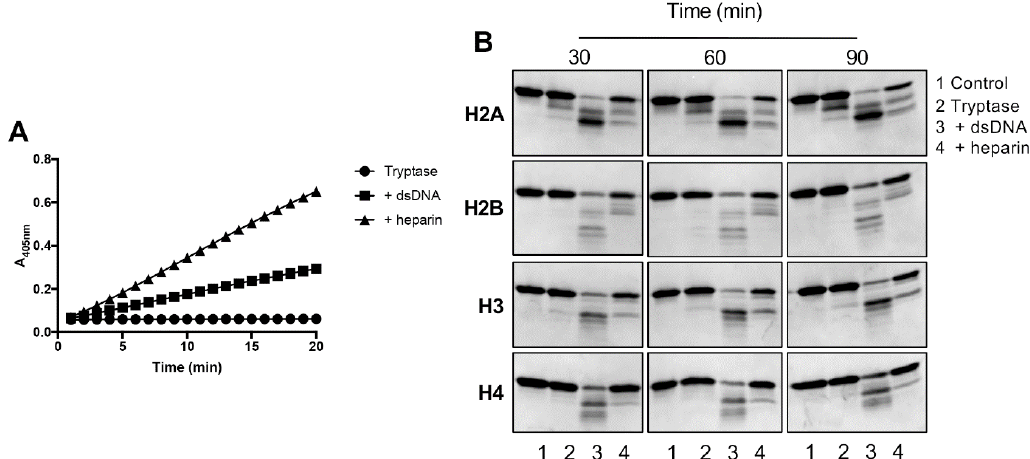
Figure 5. DNA-stabilized tryptase degrades core histones. β -tryptase (1 ng / µ L) in PBS was incubated for 1 h at 37 ◦ C, either alone or in the presence of either dsDNA (5 ng / µ L) or heparin (5 ng / µ L) as indicated; monitoring of residual enzymatic activity against the chromogenic substrate S-2288 is shown in ( A ). ( B ) Next, core histones (H2A, H2B, H3, H4; 260 ng) were added, followed by incubation for 30, 60 or 90 min (37 ◦ C). Samples were then separated by SDS-PAGE, followed by visualization of bands by InstantBlue. The data are representative of three independent